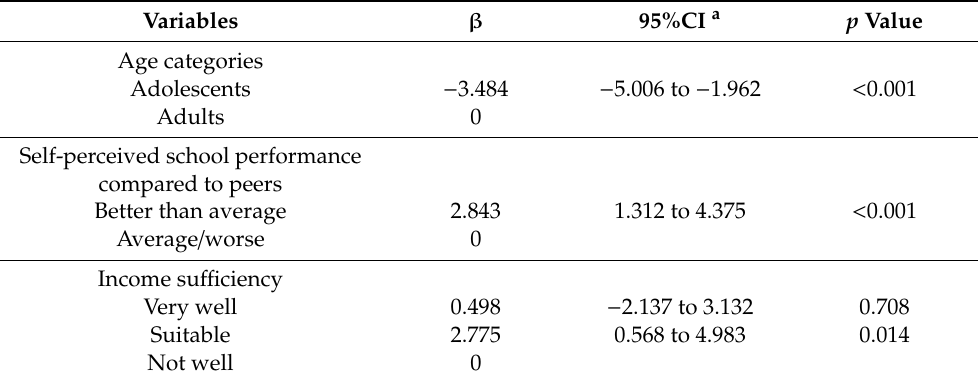
Linear regression model for the associations among independent variables and the SAHLPA-18